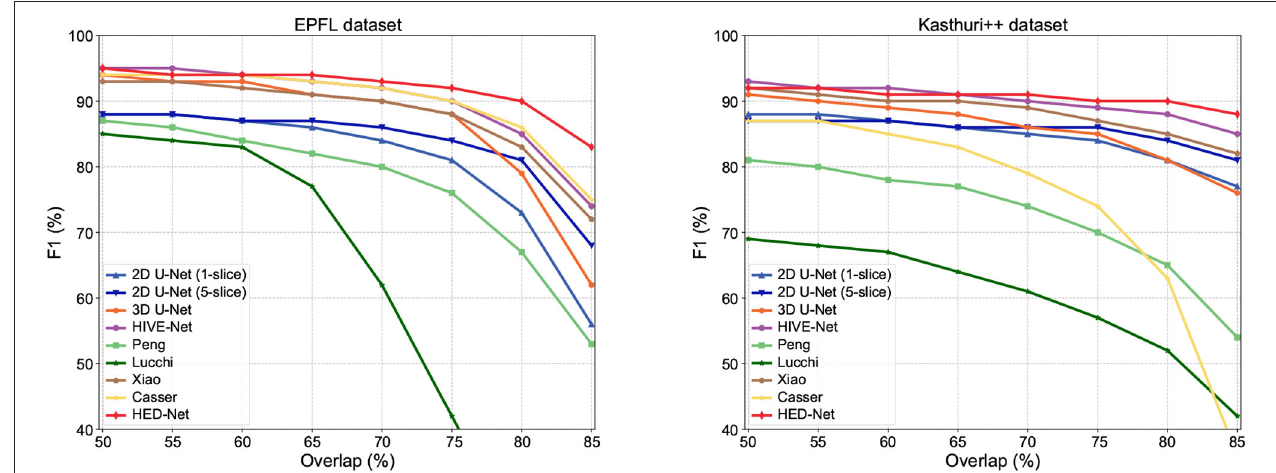
FIGURE 6 | Detection performance in F1 with different overlapping thresholds for matched instances. As the overlapping thresholds increase, the F1 of all methods has decreased, but our method maintains the highest stability.